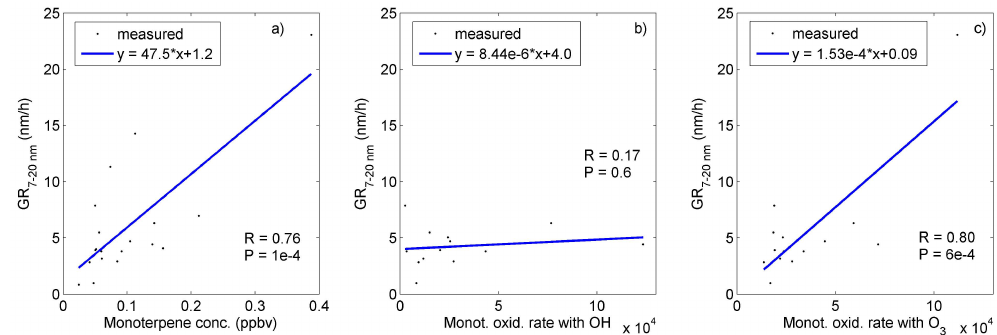
Fig. 9. Growth rate (GR) of particles in the size ranges 7–20nm as a function of event time median (a) concentration of monoterpenes, measurement based calculated oxidation rates of monoterpenes with (b) OH and (c) O 3 . Also shown are the linear fits and the correlation